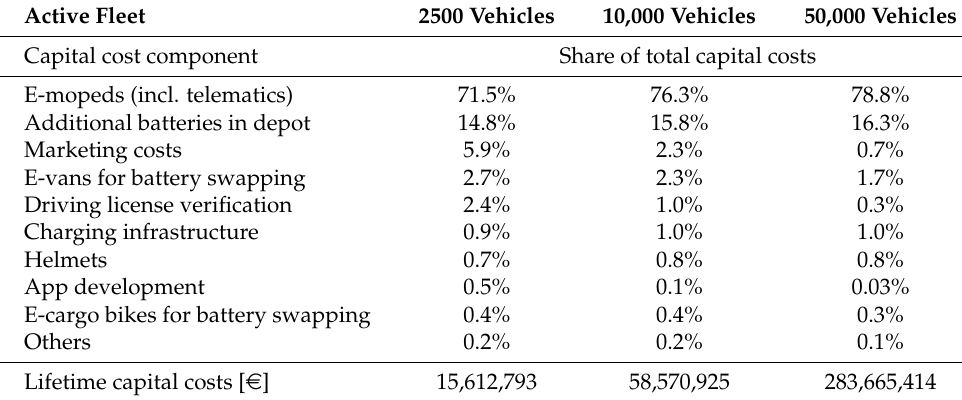
Table 3. Capital cost components for the main scenarios.